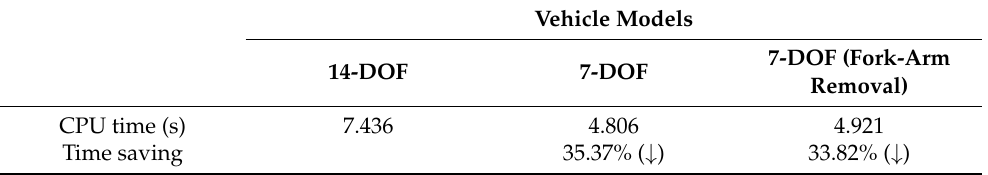
Table 3. Efficiency of different vehicle models in 20 s simulation (bumpy